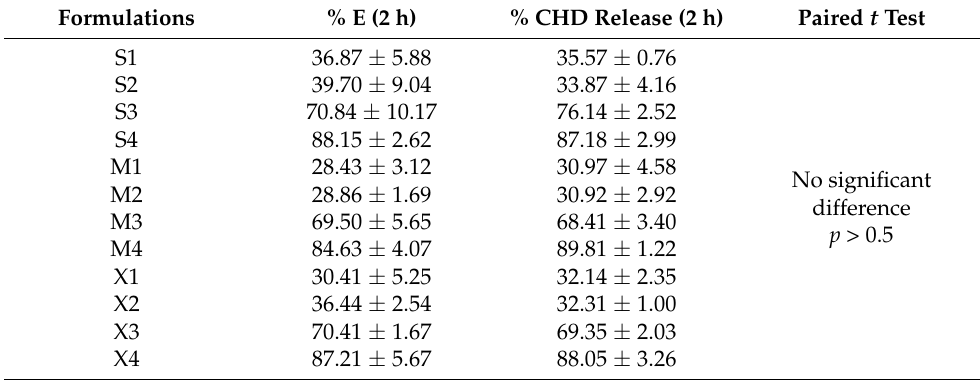
Table 4. E% and CHD% release using the CFR method at the two-hour point ( ± SD, n = 3). Formulations % E (2 h) % CHD Release (2 h) Paired t Test S1 36.87 ± 5.88 35.57 ± 0.76